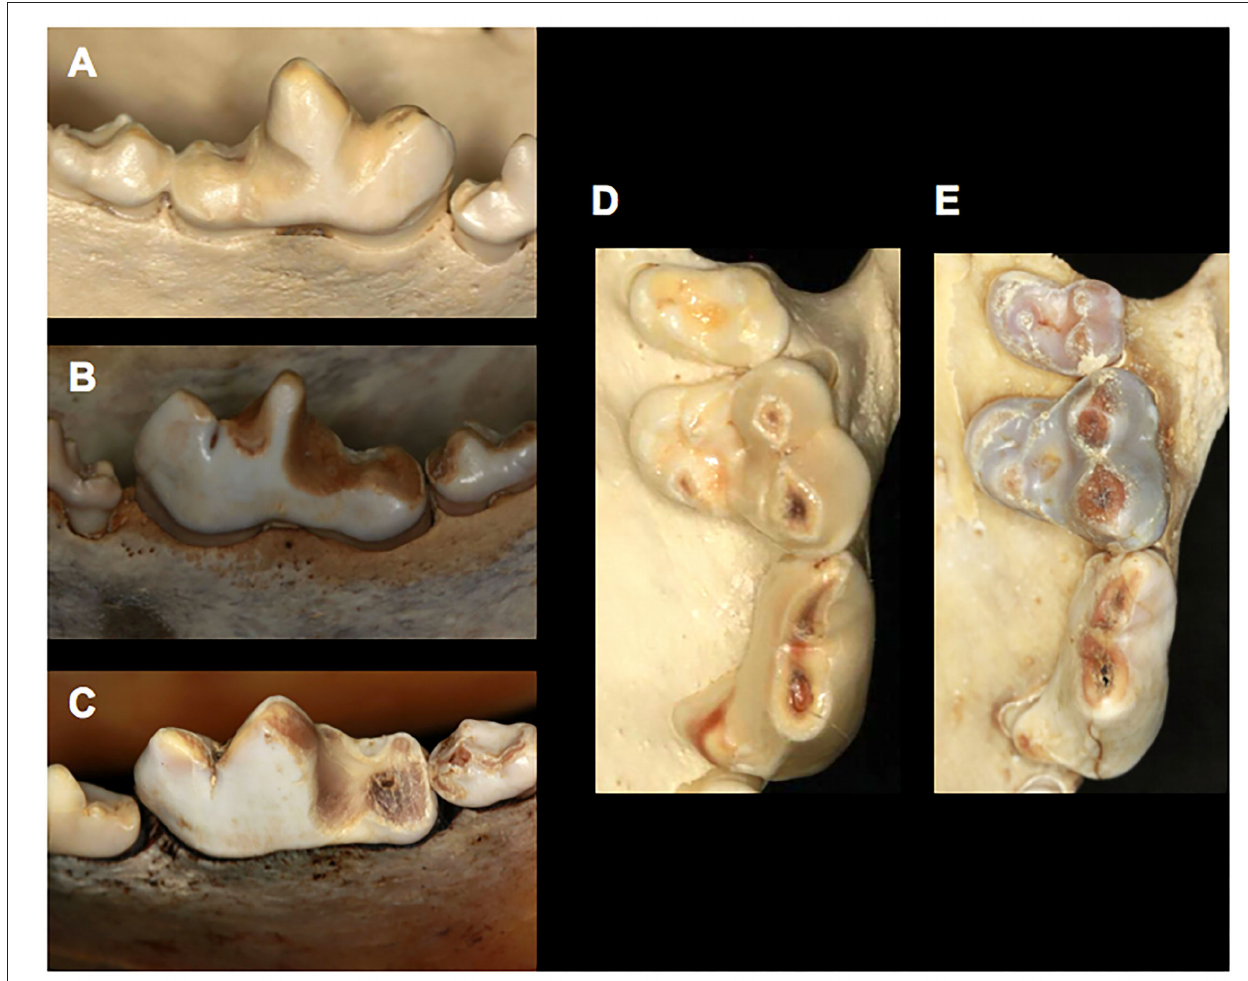
FIGURE 5 | Different Gray wolf ( Canis lupus) specimens with signs of attrition/abrasion: (A) mild attrition and abrasion of a right mandibular first molar tooth (UAM100504, unknown sex), (B) moderate attrition and abrasion of a left mandibular first molar tooth (UAM 24108, female), (C) severe attrition and abrasion of a left mandibular first molar tooth (UAM 21244, male), (D) minimal attrition and abrasion on a right maxillary second molar tooth and moderate attrition and abrasion on a maxillary first molar and fourth premolar tooth (UAM 70584, female) and (E) mild attrition and abrasion on a right maxillary second molar tooth, moderate attrition and abrasion on a maxillary first molar tooth and severe attrition and abrasion on a right maxillary fourth premolar tooth (UAM 101217, female).